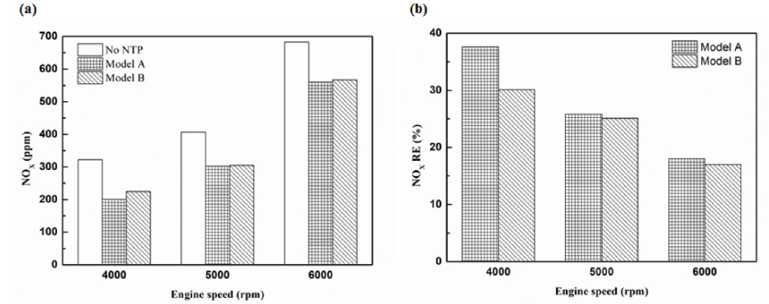
Figure 33. The NO x ( a ) emission values and ( b ) RE of control voltage 5 V using iridium alloy.